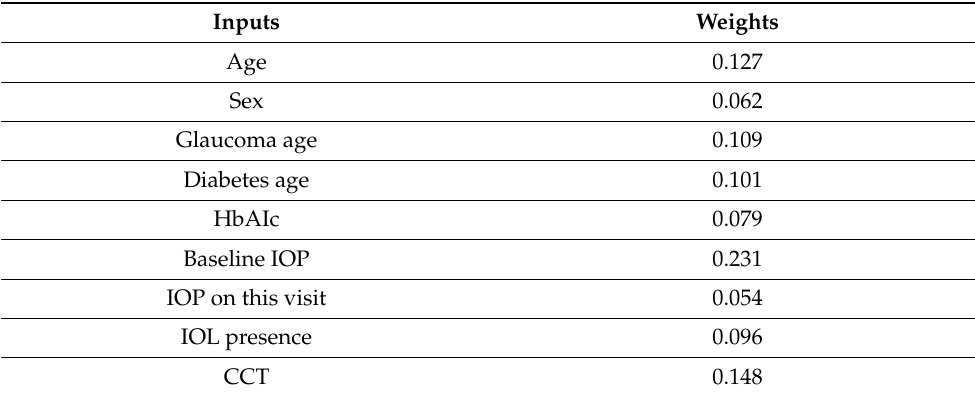
Table 4. The weights for each input in relation to the MD output calculated with the NNGE algorithm.